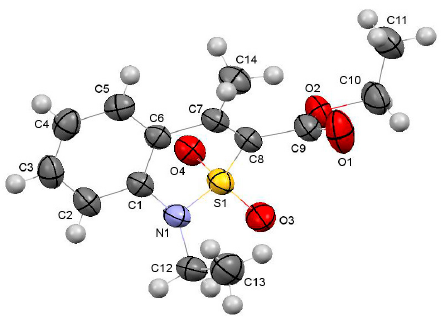
Figure 2. The spatial structure of 1-ethyl substituted ester 3 according to the X-ray diffraction data. The atoms are represented by thermal vibration ellipsoids of 50% probability.